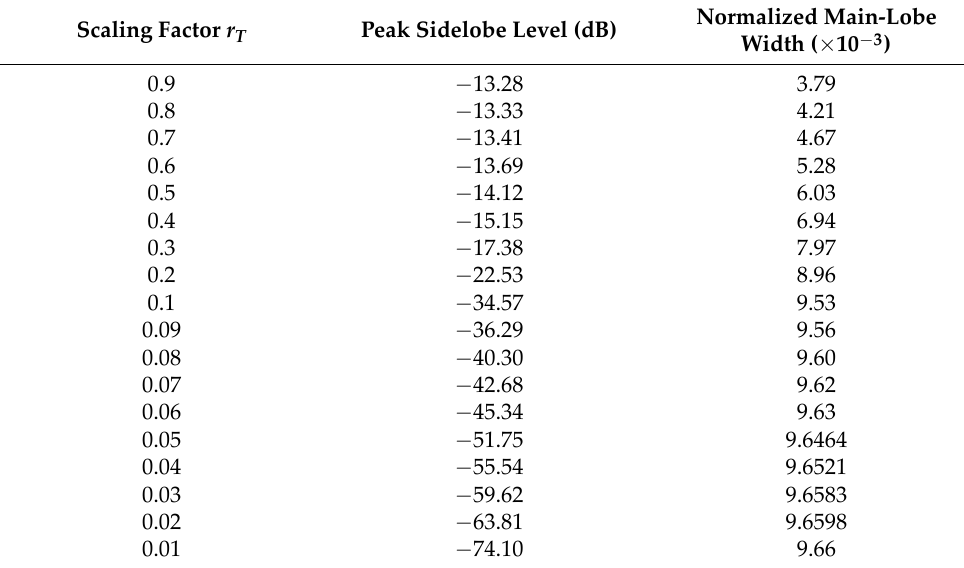
Table 3. The effect of r T on the frequency characteristics.